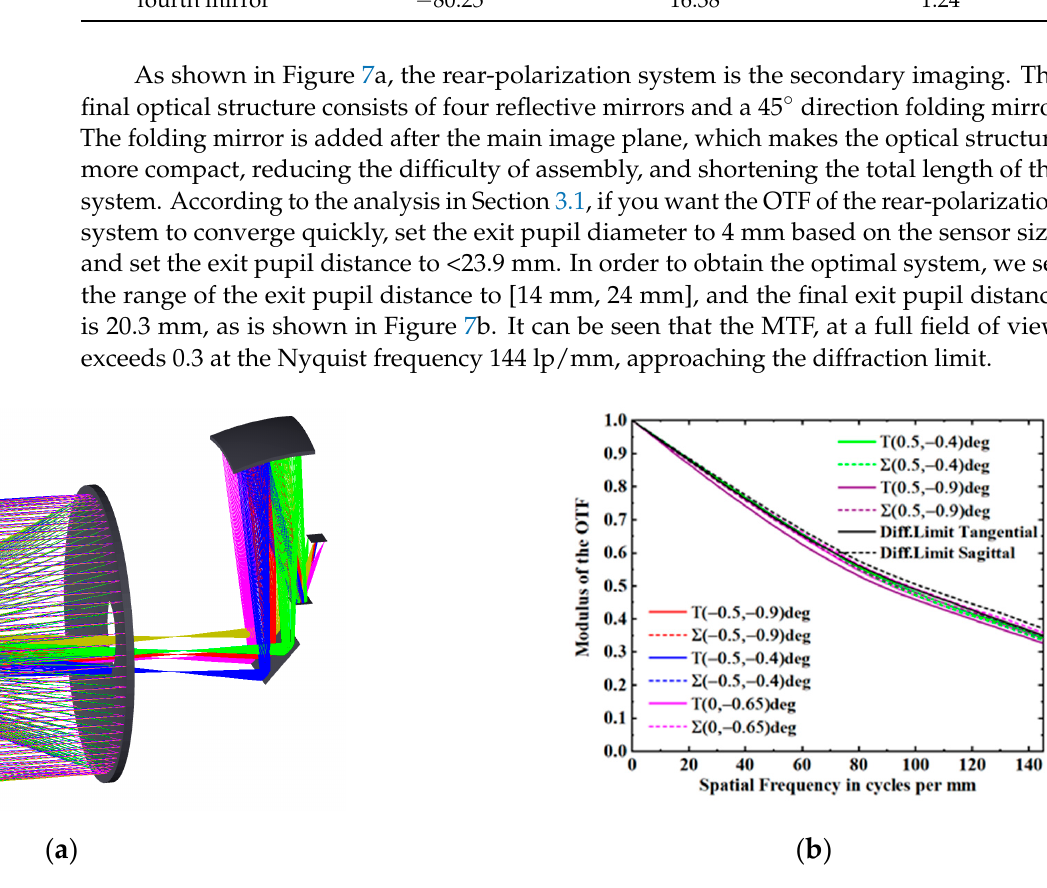
Figure 7. ( a ) Optical layout of the rear-polarization system ( b ) modulation transfer function of the rear-polarization system.